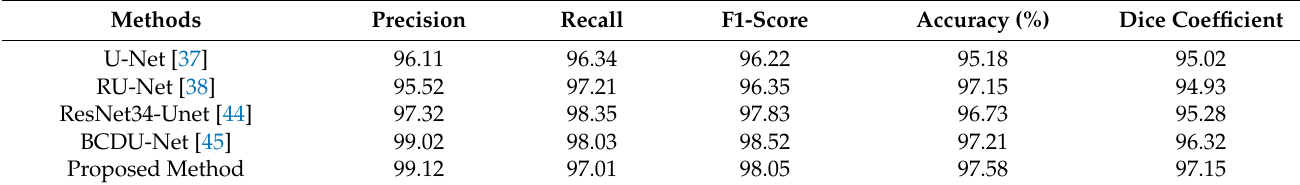
Table 1. Comparison of proposed network performance and the state-of-the-art alternatives on LIDC-IDRI dataset. Methods